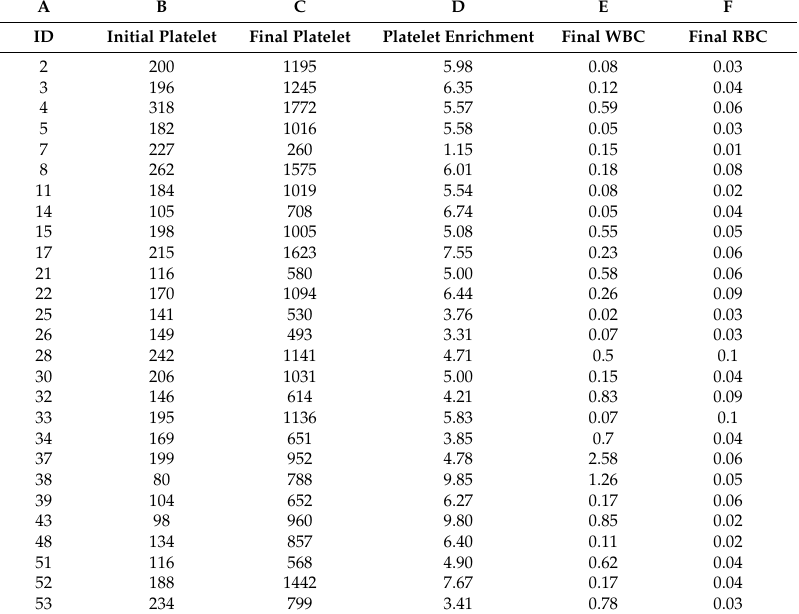
Table 3. PRP composition. A: Patient Identification number; B: Initial platelet count (10 9 /L); C: Final platelet count after processing (10 9 /L); D: platelet enrichment (C/B); E: Final white blood cell concentration (10 9 /L); F: Final Red Blood cell concentration (10 9